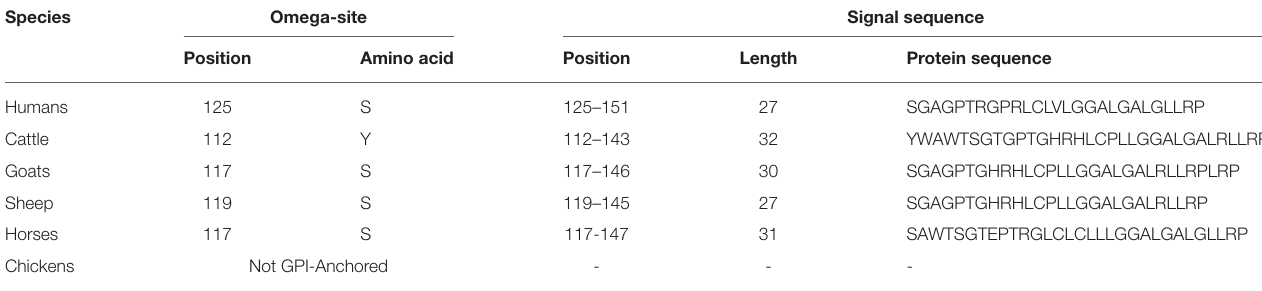
TABLE 4 | Prediction of the omega-site and signal sequences of the glycosylphosphatidylinositol (GPI)-anchor of Sho by PredGPI. Species